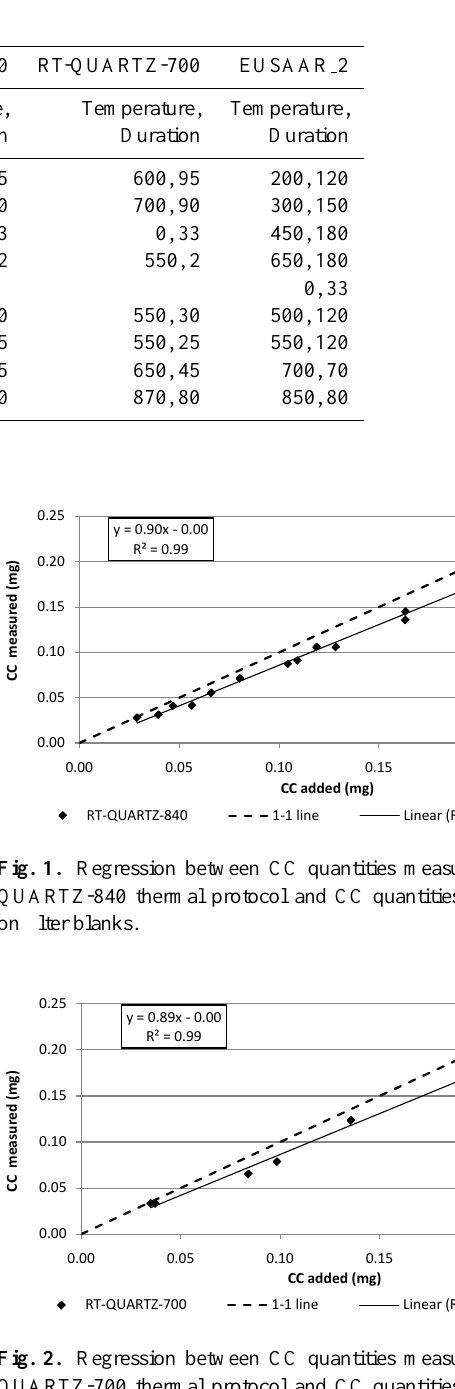
Table 2. Thermal protocols used: Temperature ( ◦ C), Duration (s).